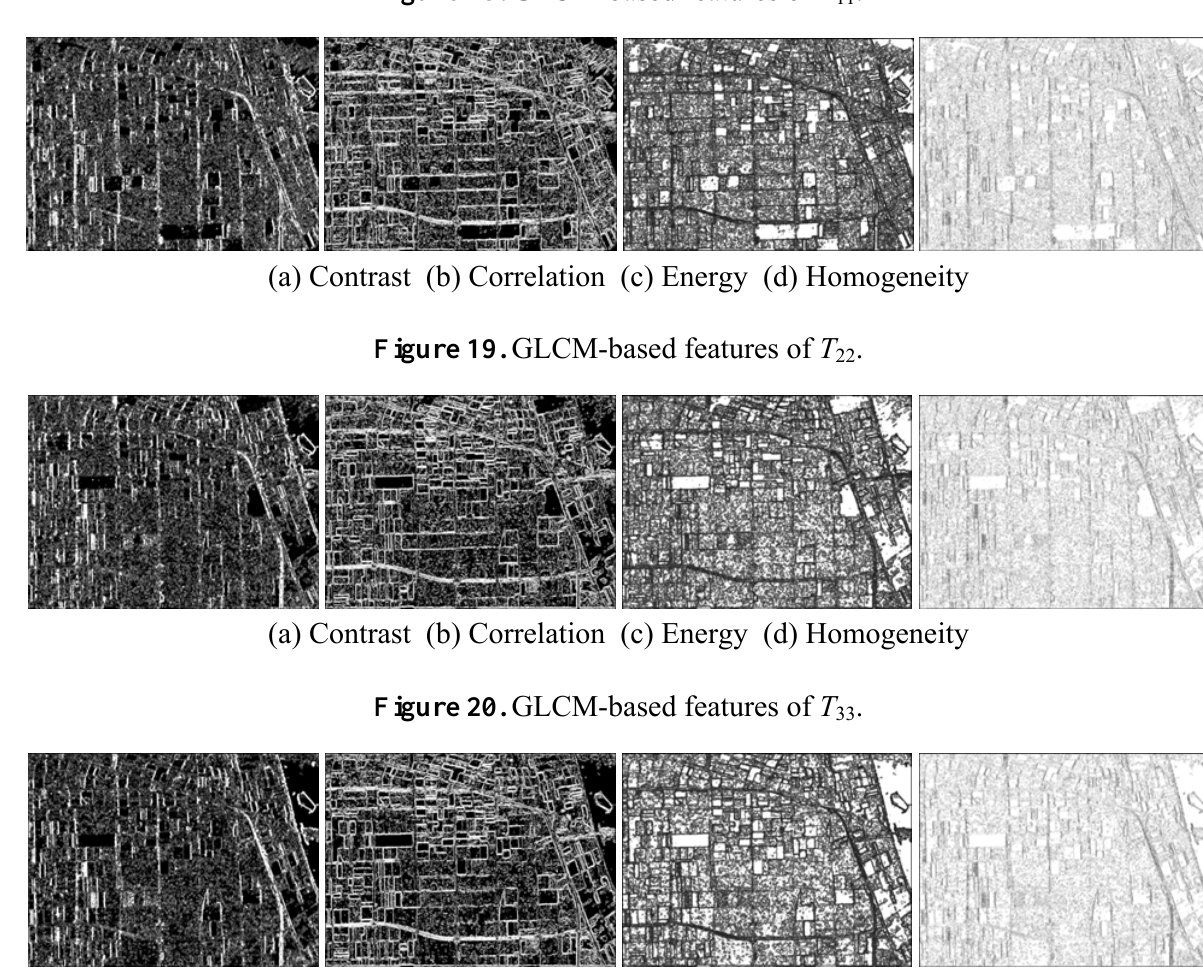
Figure 18. GLCM-based features of T